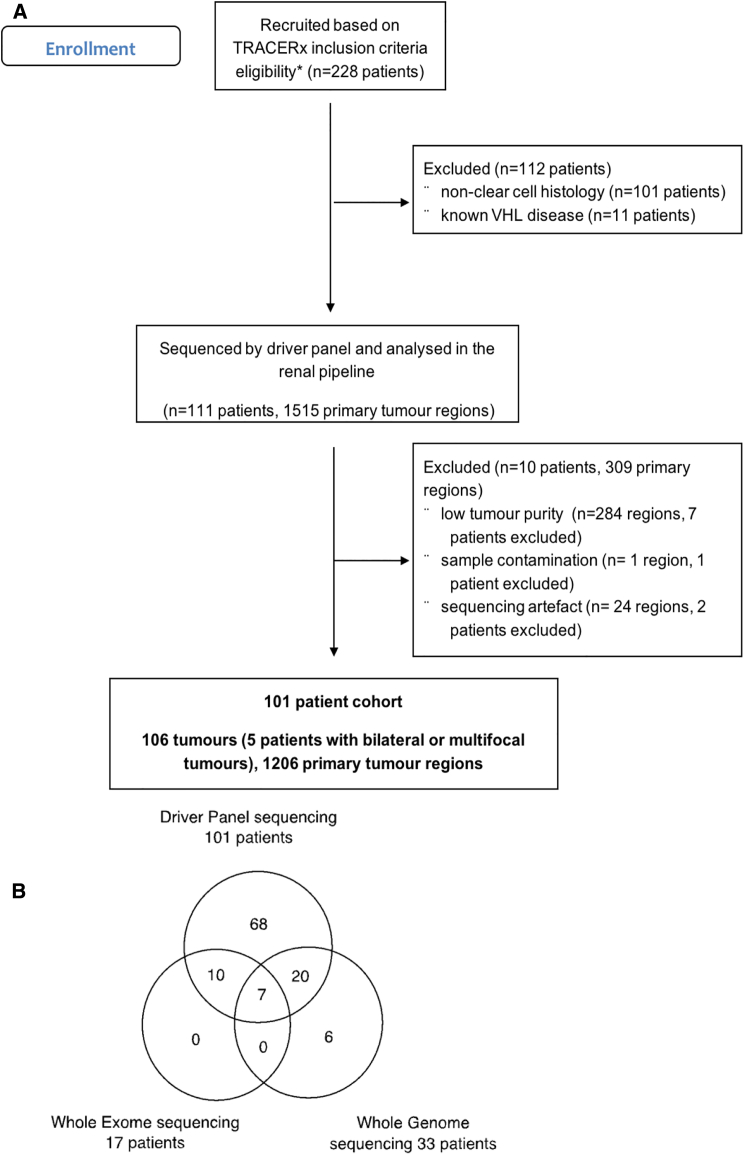
Consort Diagram, Related to STAR Methods(A and B) (A) shows the Consort diagram for the filtering steps leading to the reported cohort; (B) shows the summary of Driver Panel, Whole Exome and Whole Genome Sequencing in the TRACERx Renal 101 Cohort.